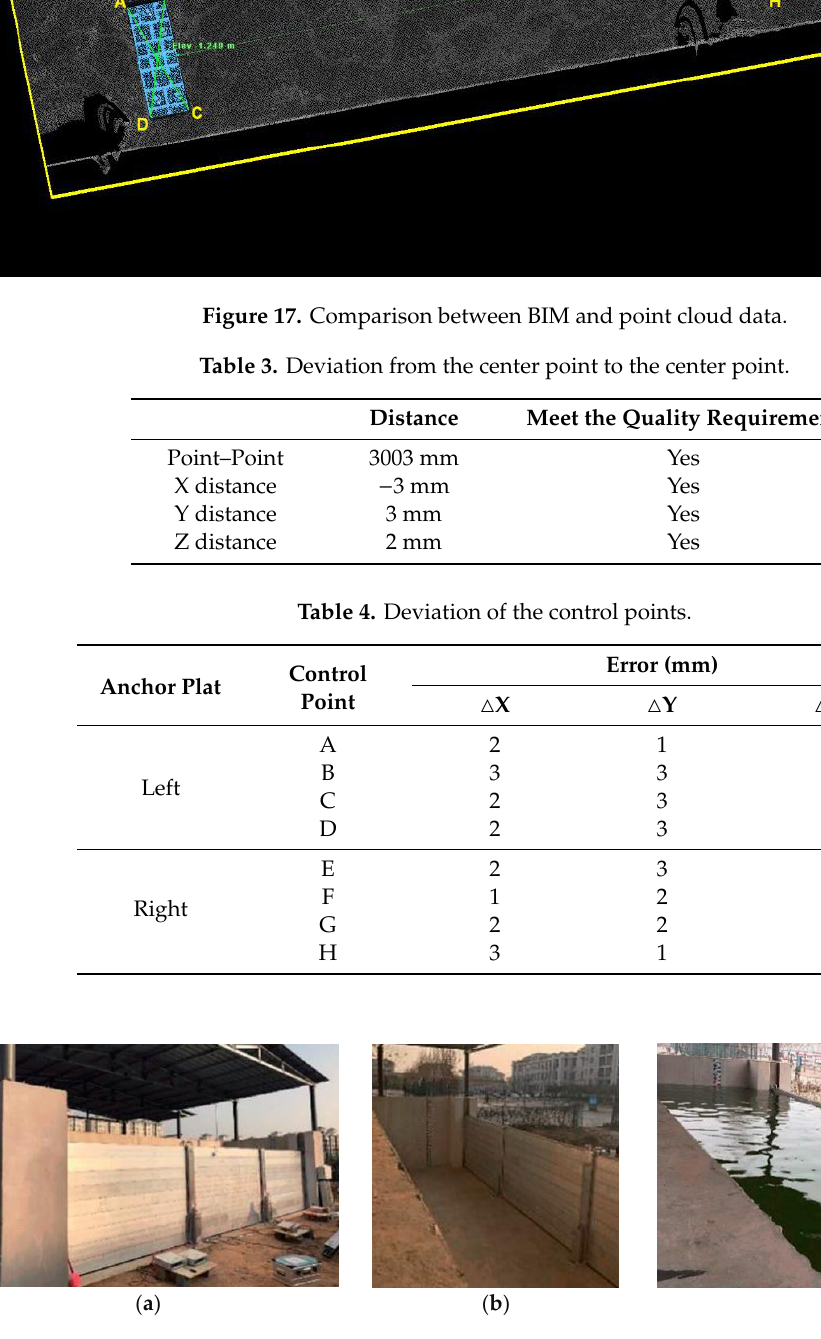
Figure 18. Floodwall performance test [5]: ( a ) Floodwall testing site, ( b ) no water, ( c ) with water (at 1.8 m height).